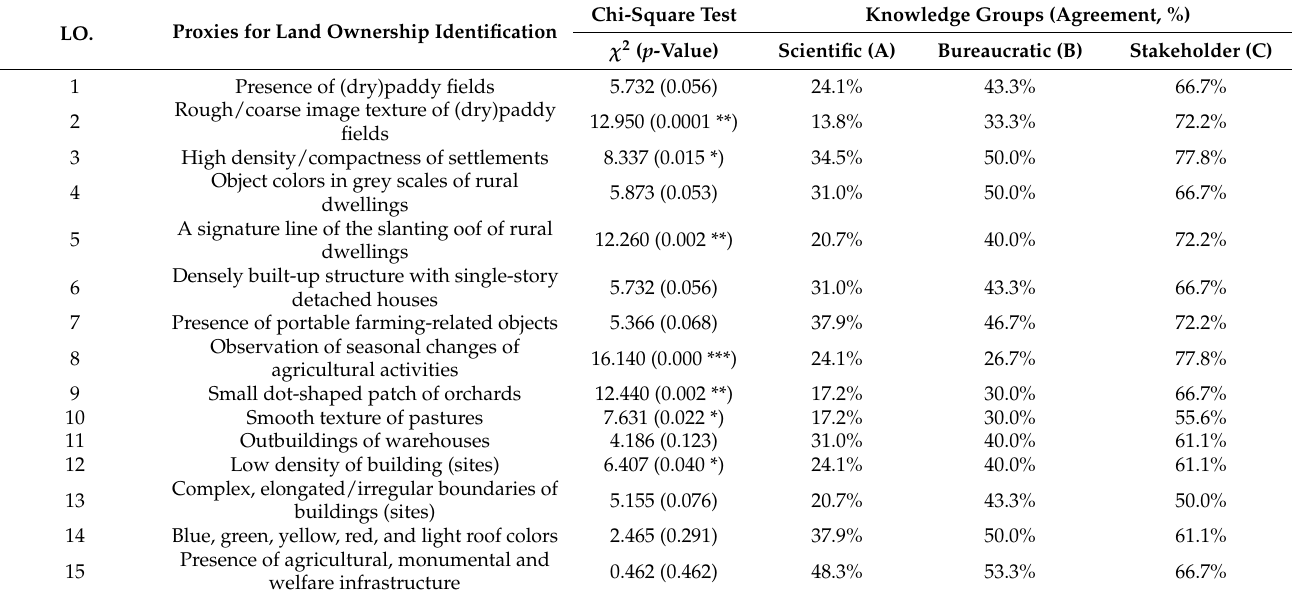
Table 2. Validating the suitability of proxies for land ownership identification and differences between knowledge groups.